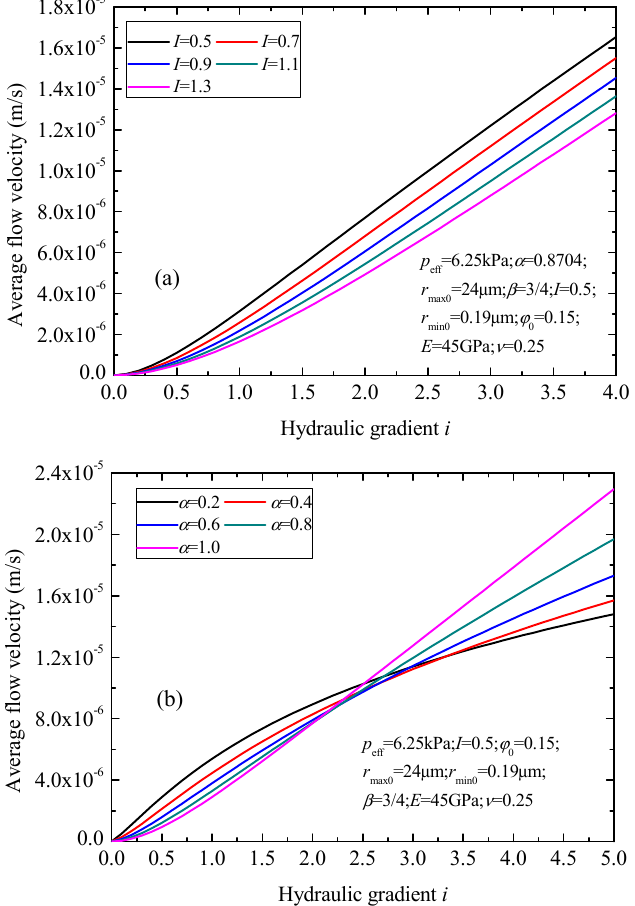
Figure 3. The average flow velocity curves: ( a ) for different threshold hydraulic gradient I ; ( b ) for different differential order α .